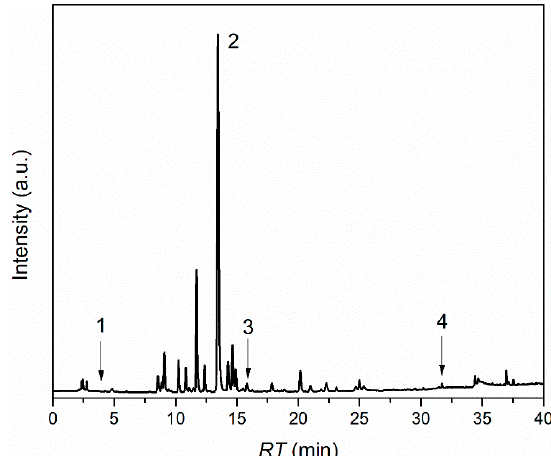
Figure 1. Chromatogram of Lycium barbarum; 1—gallic acid: RT = 3.62 min; c = 0.231 ± 0.002 mg/g extract; 2—chlorogenic acid: RT = 13.15 min; c = 18.740 ± 0.031 mg/g extract; 3—caffeic acid: RT = 14.48 min; c = 1.773 ± 0.002 mg/g extract; 4—rosmarinic acid: RT = 31.48 min; c = 0.108 ± 0.002 mg/g extract.